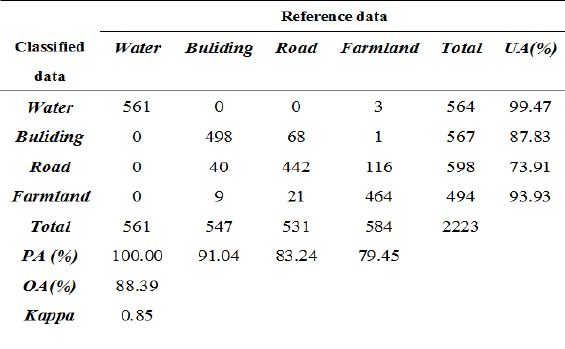
Table 2. Classification Accuracy of the Proposed Method